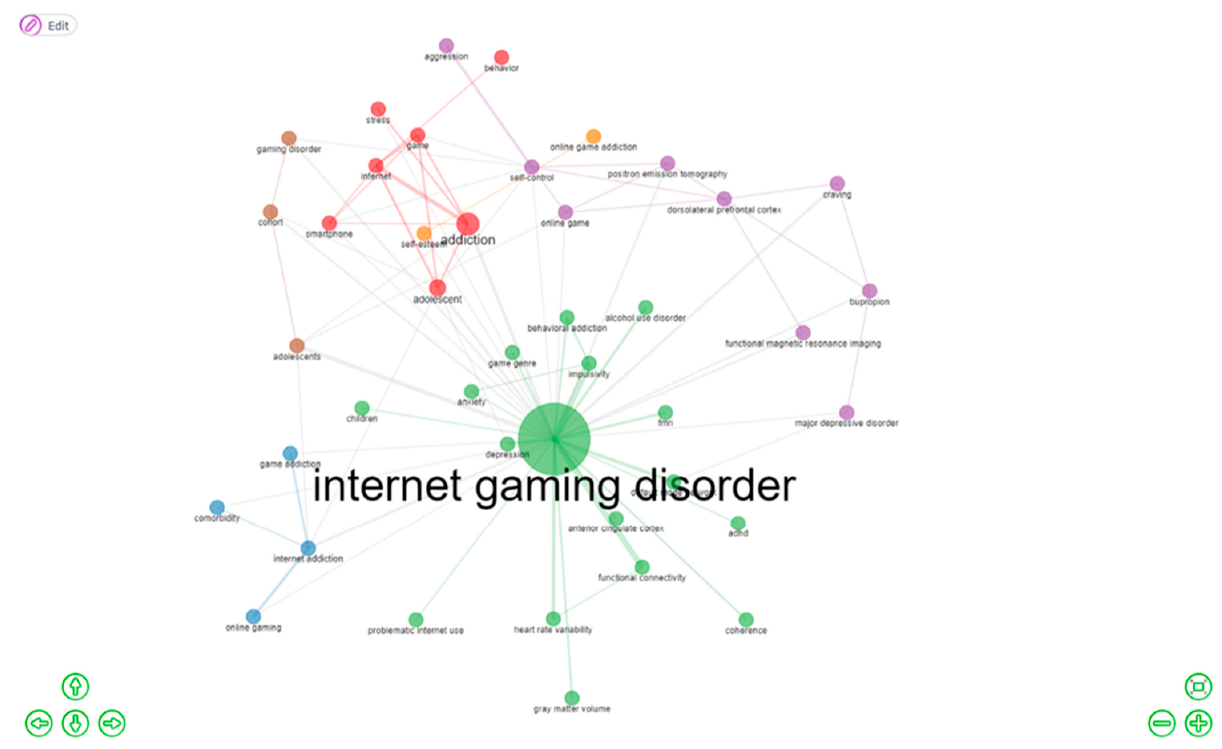
Figure 5. Co-occurrence network of authors’ keywords.